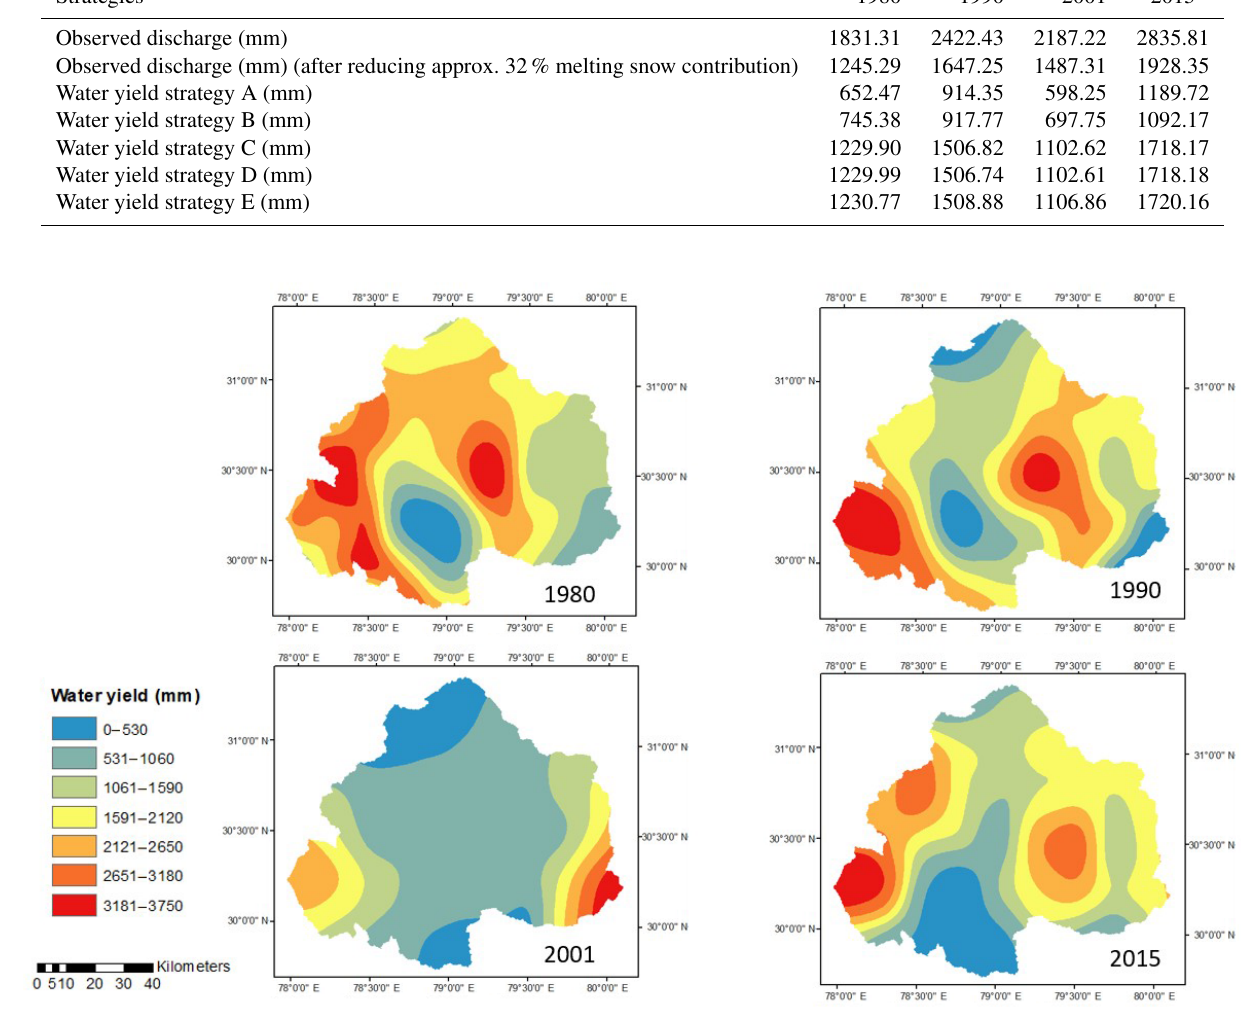
Figure 5. Water yield obtained by taking the single weighted mean value of parameter “ w ” from Xu et al. (2013) for the global